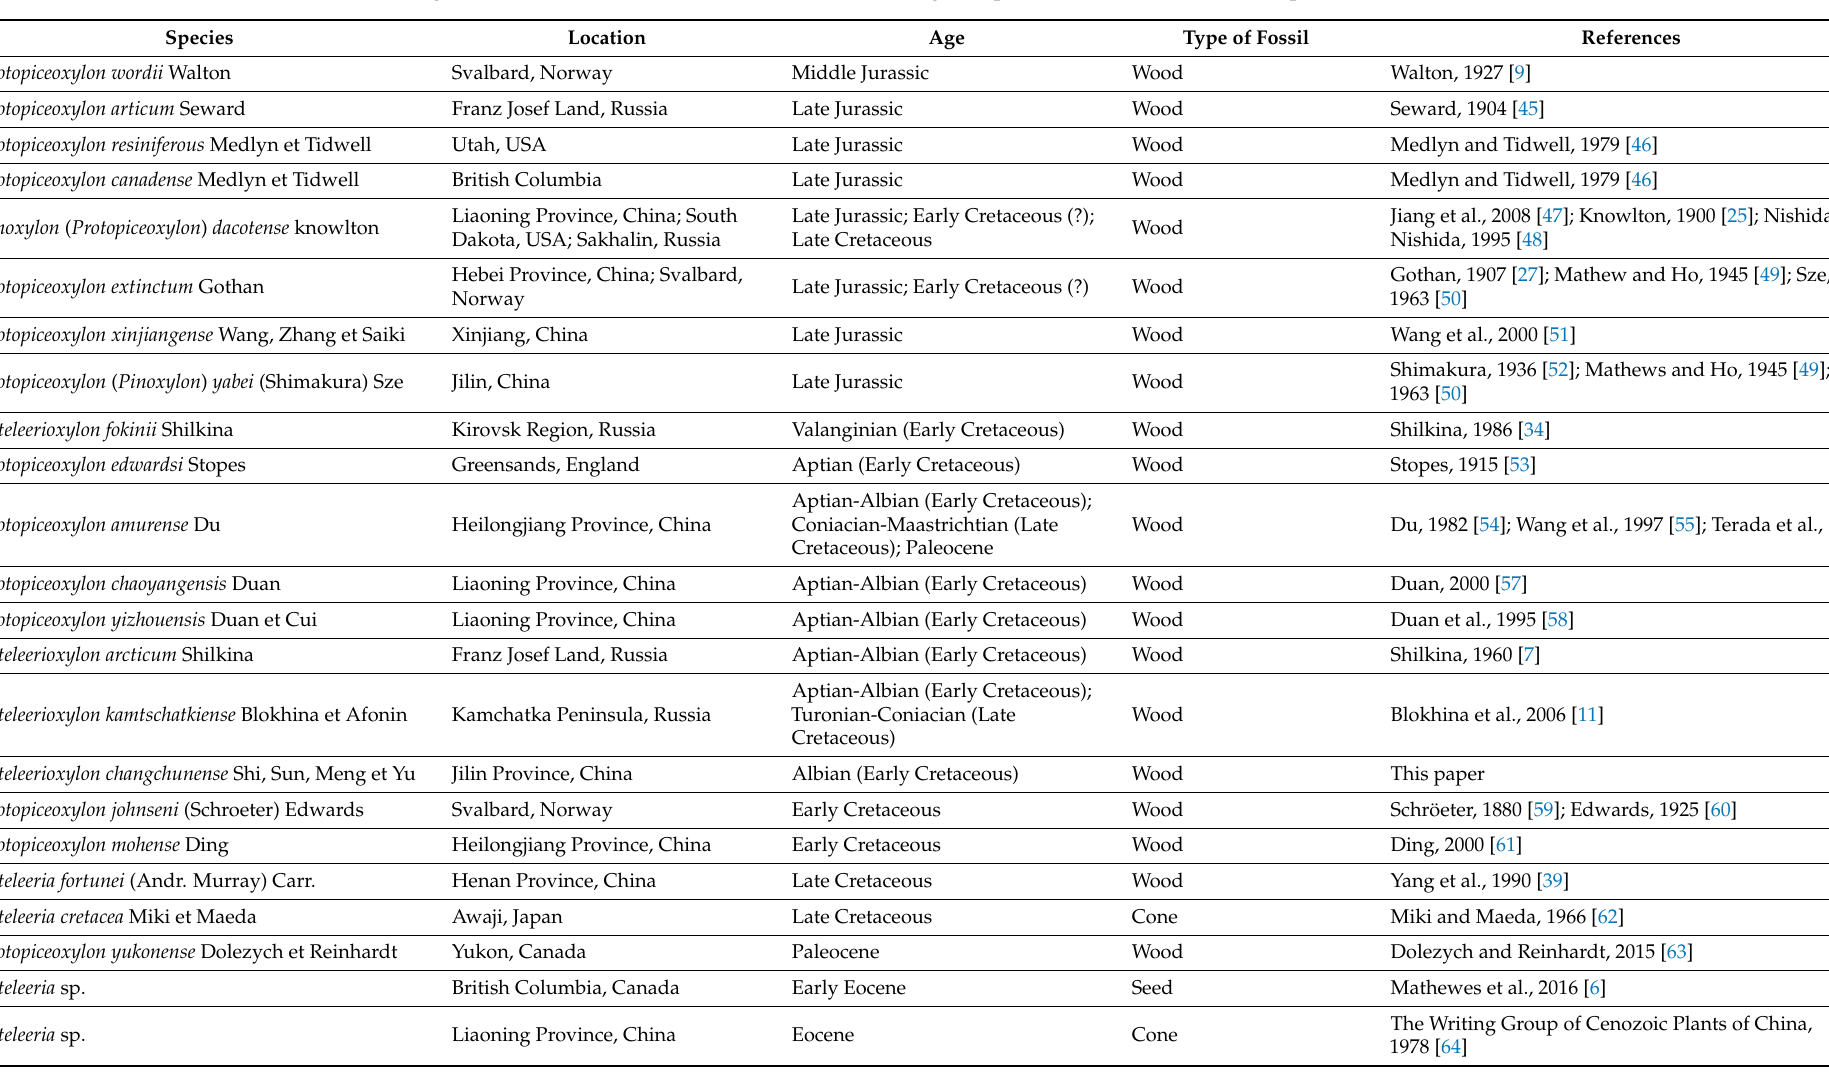
Table 4. Geological distribution of Keteleeria -like fossils (excluding the species without detailed